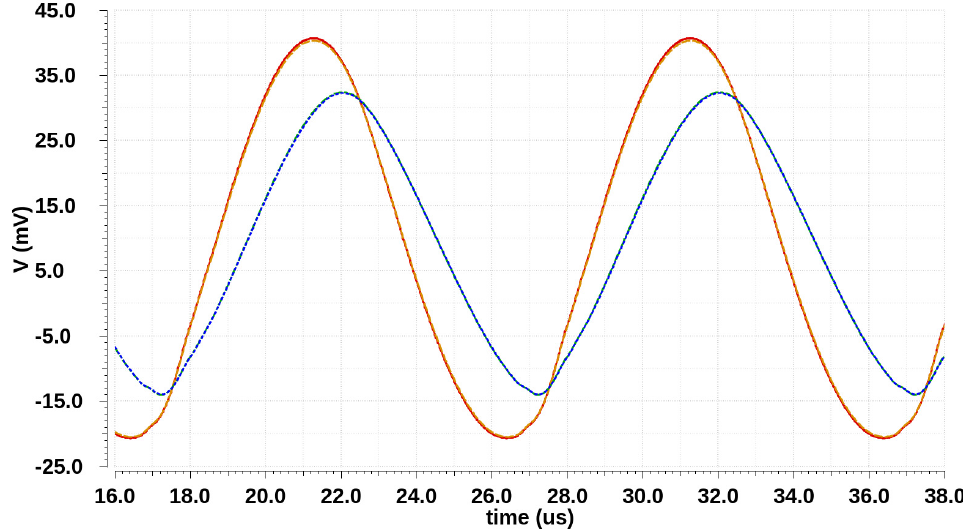
Figure 15. Time-domain curves of differences between the output and input sinusoidal waveforms at 100 kHz: the original buffer—blue dotted line; the SOAC buffer—green dashed-dotted line; the laid-out original buffer—orange dashed line; the laid-out SOAC buffer—red solid line.